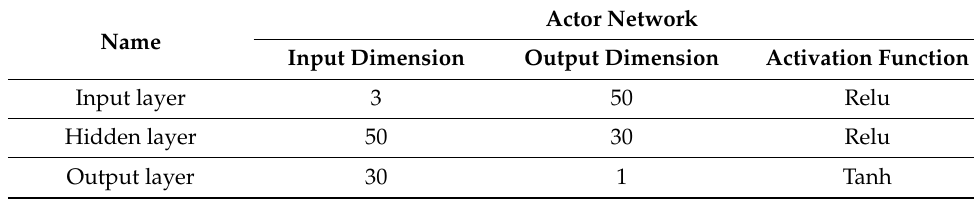
Table 1. Actor network